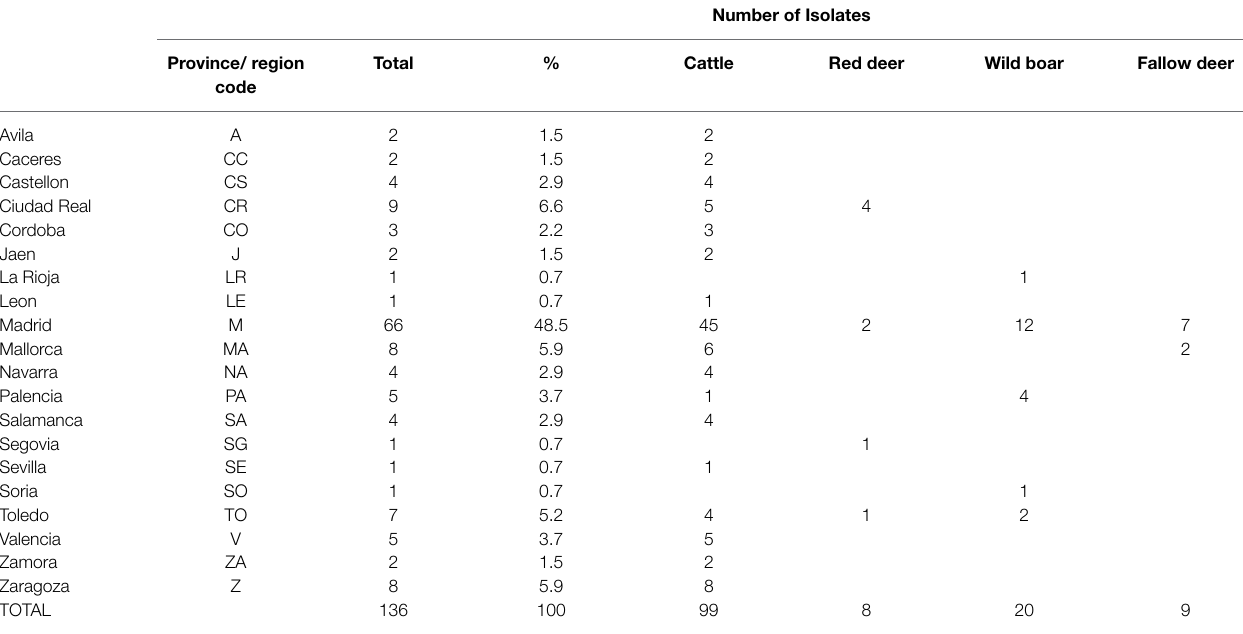
TABLE 1 | Number of cattle, red deer, wild boar, and fallow deer sequenced isolates per province and overall included in the